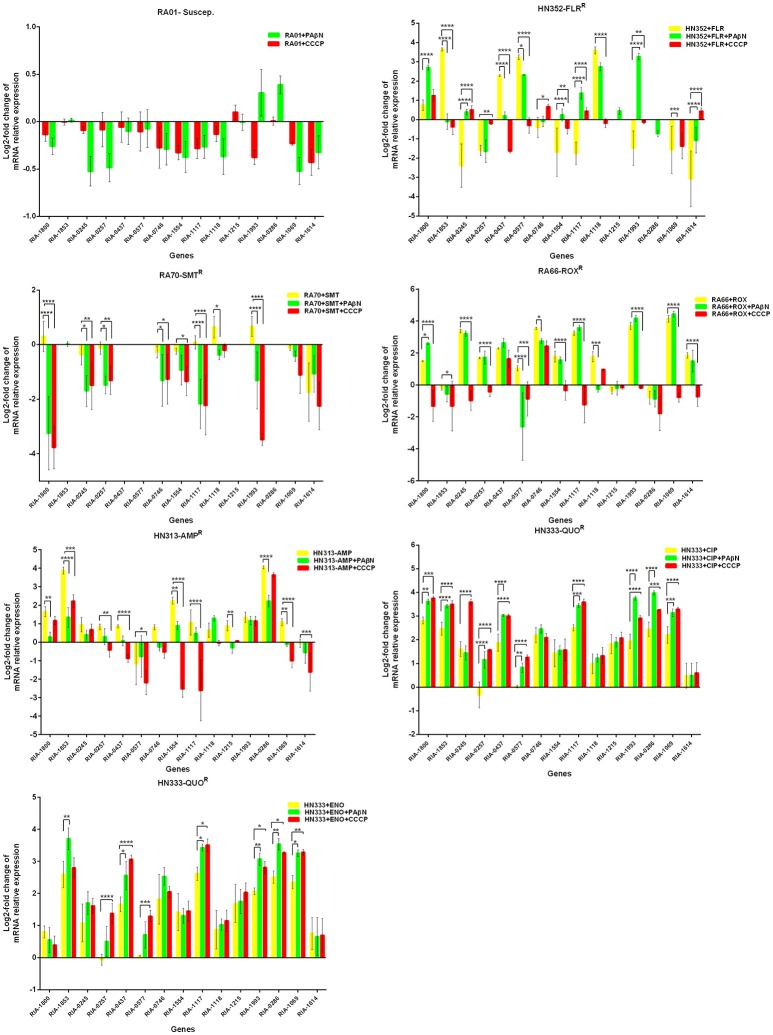
Quantification of the relative mRNA expression levels of a panel of EPGs in mono-resistant strains. Strains were grown in the presence of half MIC of each antibiotic; CCCP (5 μg/mL) and PAβN (40 μg/mL), showed no effects on the growth of R. anatipestifer isolates. The MICs of the antibiotics and EPIs were determined for each strain and are presented in Table 4. Change in the level of transcription of EPGs was measured as fold change normalized to recA gene expression and was subsequently calculated as log2-fold change that is relative to the untreated cell culture. Levels of significance were set as follows: *P < 0.05 was considered statistically significant and **P < 0.01, ***P < 0.001, and ****P < 0.0001 were all considered highly significant.